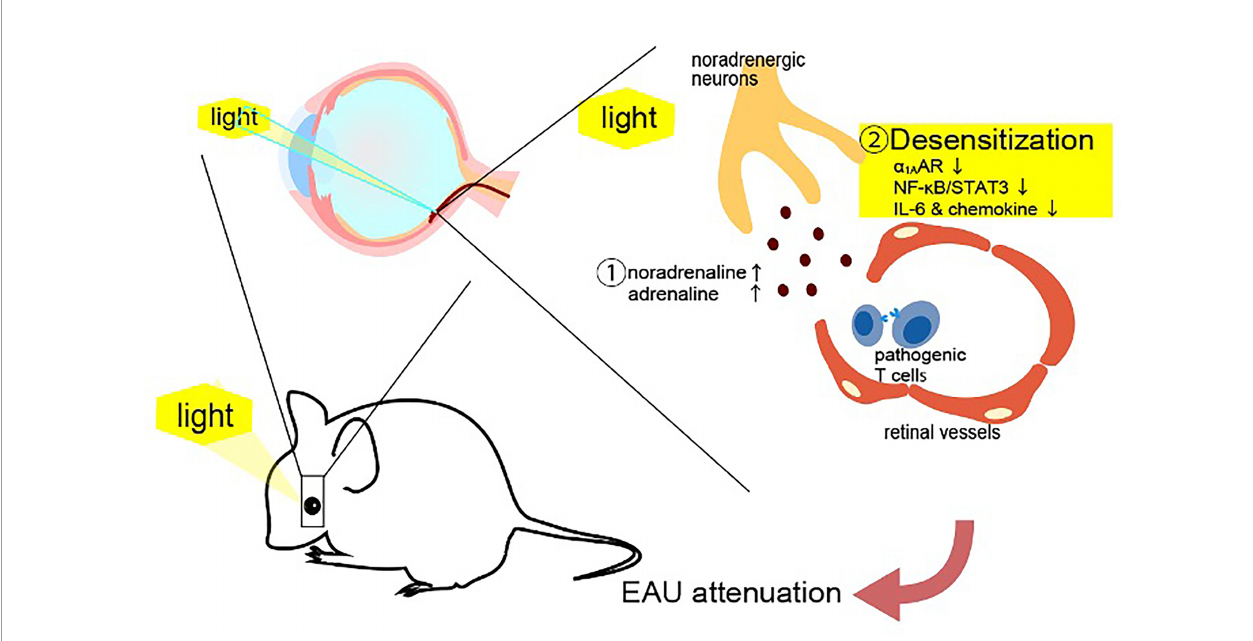
FIGURE 5 | Stress gateway re fl ex. Chronic stresses including light sleep activate noradrenergic neurons in the paraventricular nucleus (PVN) to establish gateways for immune cells at speci fi c blood vessels in the brain, particularly in the presence of myelin-speci fi c CD4 + T cells in the blood. Myelin-speci fi c CD4 + T cells accumulate at the speci fi c vessels together with major histocompatibility complex class II + monocytes to develop micro-in fl ammation there. ATP produced by the micro-in fl ammation functions as a neurotransmitter to directly activate neurons in the dorsomedial hypothalamic nucleus (DMH)/anterior hypothalamic nucleus (AHN), followed by the activation of neurons of the dorsal motor vagal nucleus (DMX). The resulting activated efferent vagus nerve causes acetylcholine-dependent gastrointestinal in fl ammation followed by hyperkalemia with heart failure and sudden